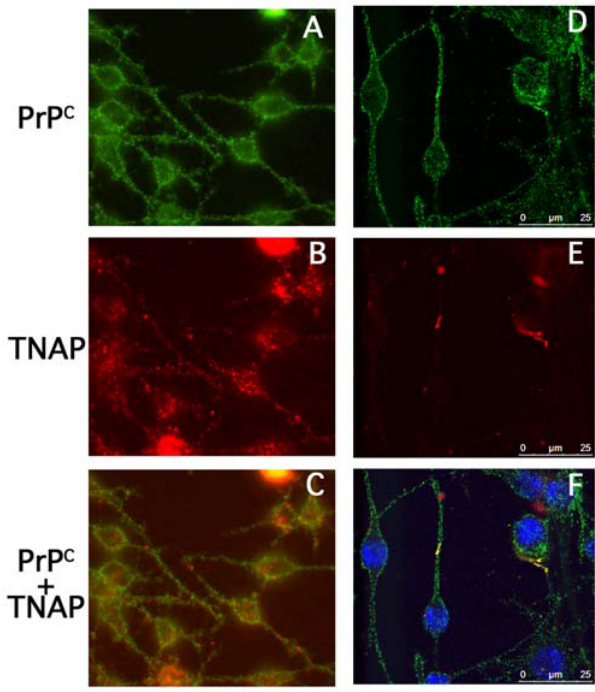
Figure 5. Co-localization of PrP C and TNAP at the surface of 1C11 5-HT cells. Membrane immunofluorescence was performed on 1C11 5-HT live cells cultured on glass coverslips. PrP C (A and D) was stained with the monoclonal SAF32 antibody and TNAP (B and E) with polyclonal anti-TNAP antibodies and revealed with alexa green or red labeled secondary antibodies, respectively. A superimposition of the two fluorescence labelings is shown in panels (C) and (F). Panels (A), (B) and (C) were obtained by epifluorescence and (D), (E) and (F) were obtained by sequential acquisition on a scanning confocal microscope.